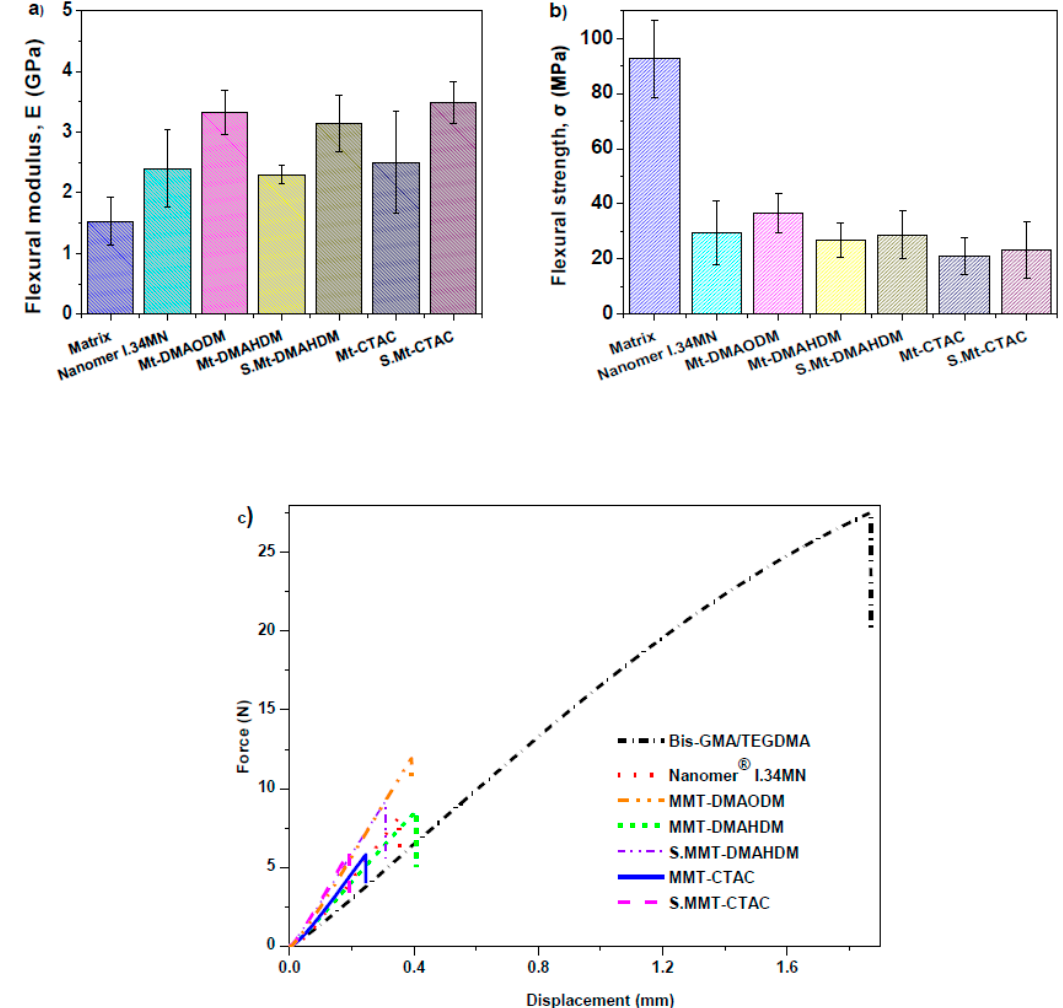
Figure 8. ( a ) Flexural modulus; ( b ) Flexural resistance;( c ) Graphic representation of force against